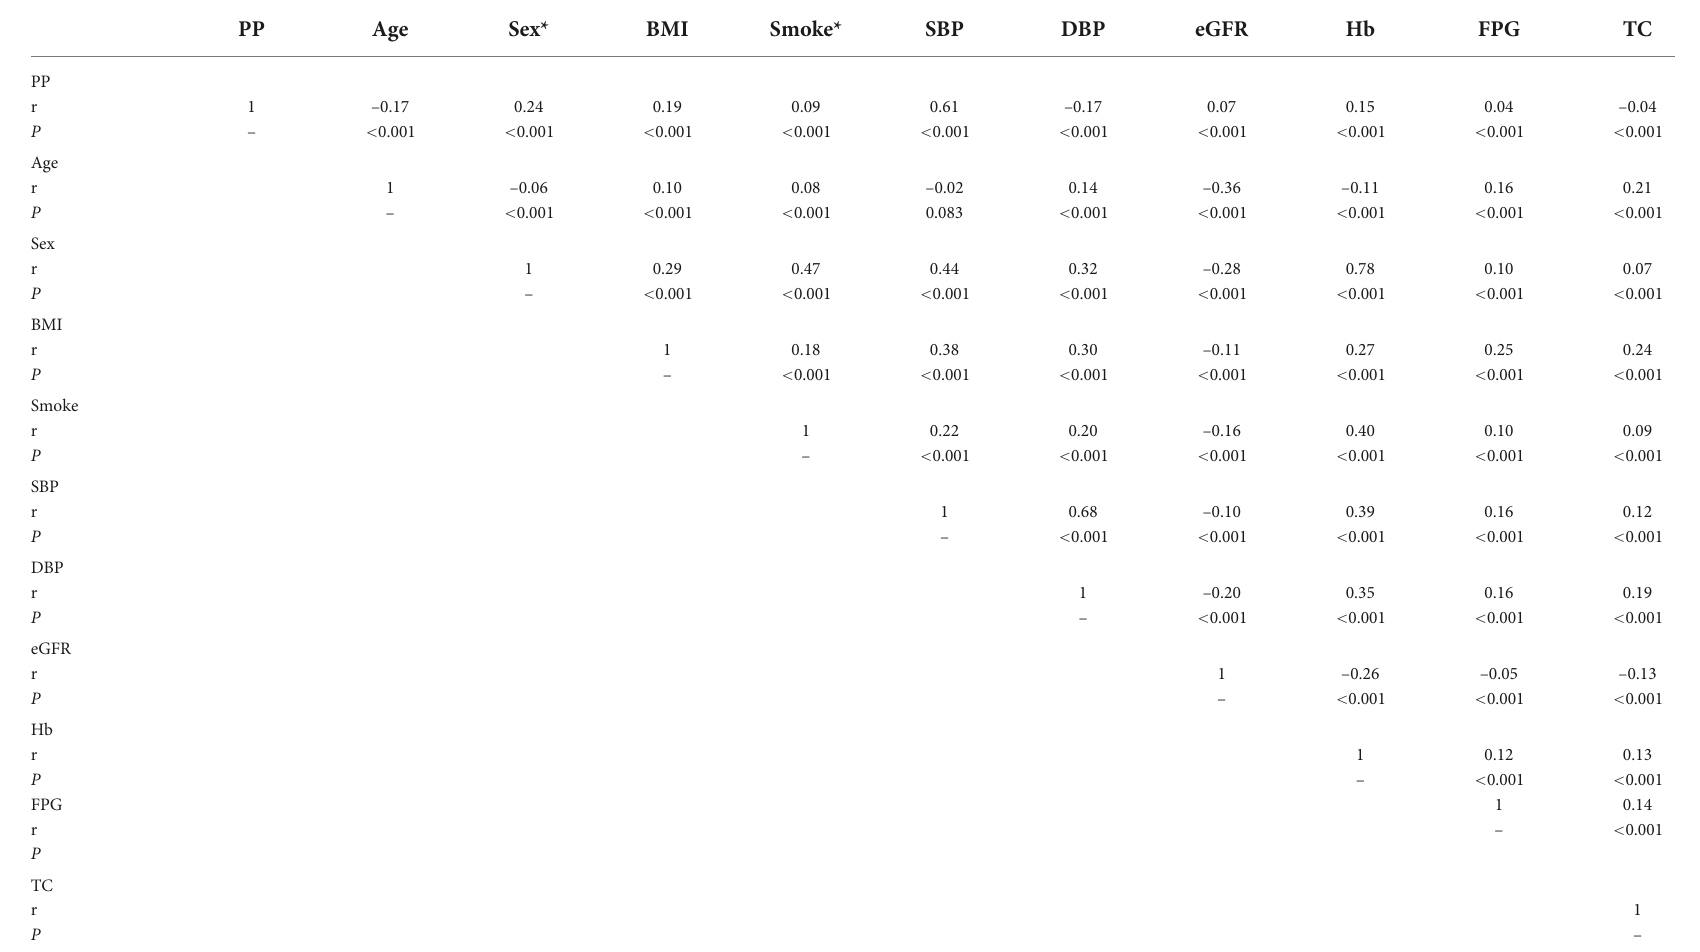
TABLE 2 The factors associated with pulse